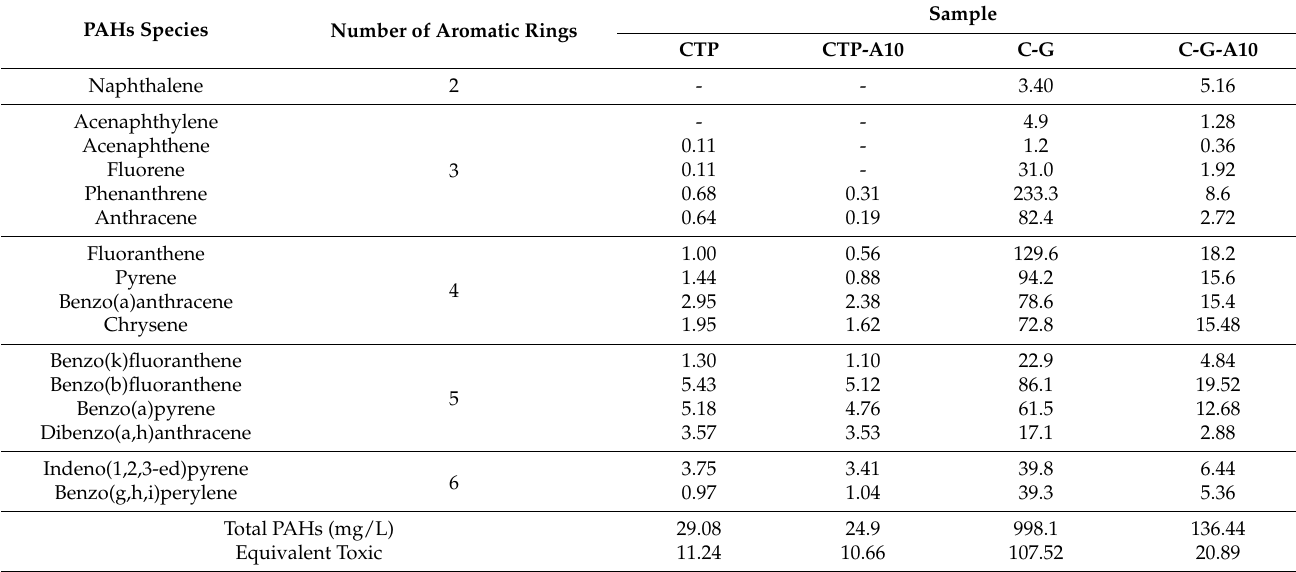
Table 7. Content and equivalent toxicity of 16 PAHs in pitch and co-carbonated flue gas.